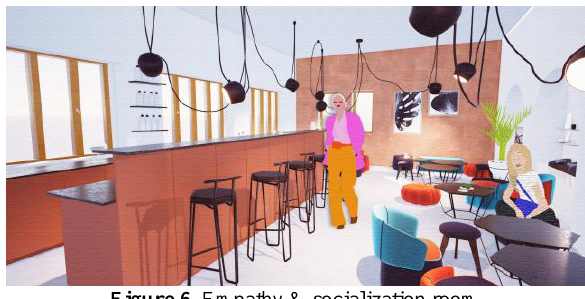
Figure 6. Empathy & socialization